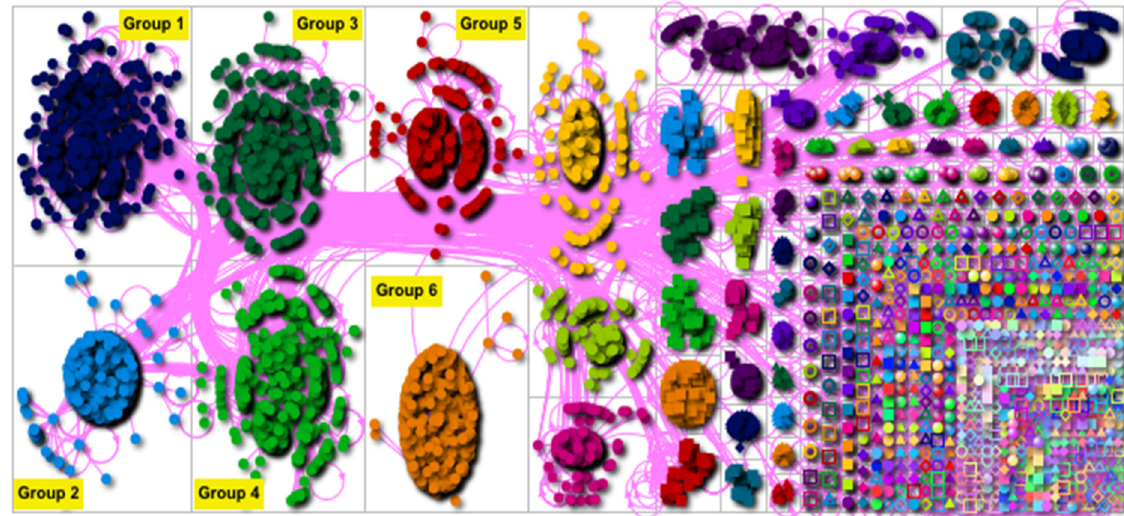
Figure 1. Social media network connections in #yonomevacuno. Graphical representation of the importance of controlling information of clusters of users, where only the six most important groups are indicated on the basis of their BCS value. Group 1 is mostly composed of users geolocated in Argentina; Groups 2 and 4 are mostly made up by users in Spain; Group 3 mainly involves users in Spain and Mexico; lastly, Group 4 is mostly composed of users in Colombia.